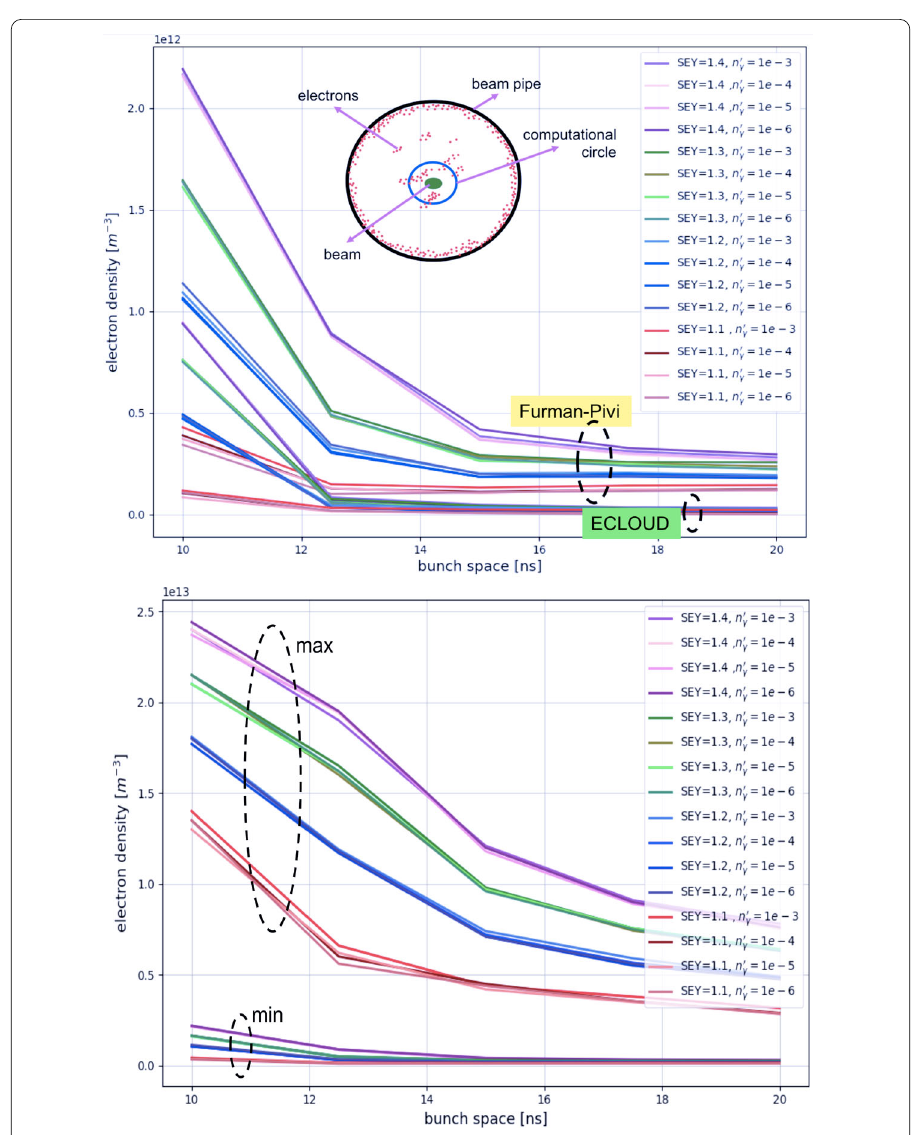
Figure 4 Electron density at the center of vacuum chamber as a function of bunch spacing. Upperfigure : Minimum central electron densities for the two SEY models, lowerfigure : Maximum and minimum central electron-cloud density in saturation, for the Furman–Pivi SEY model